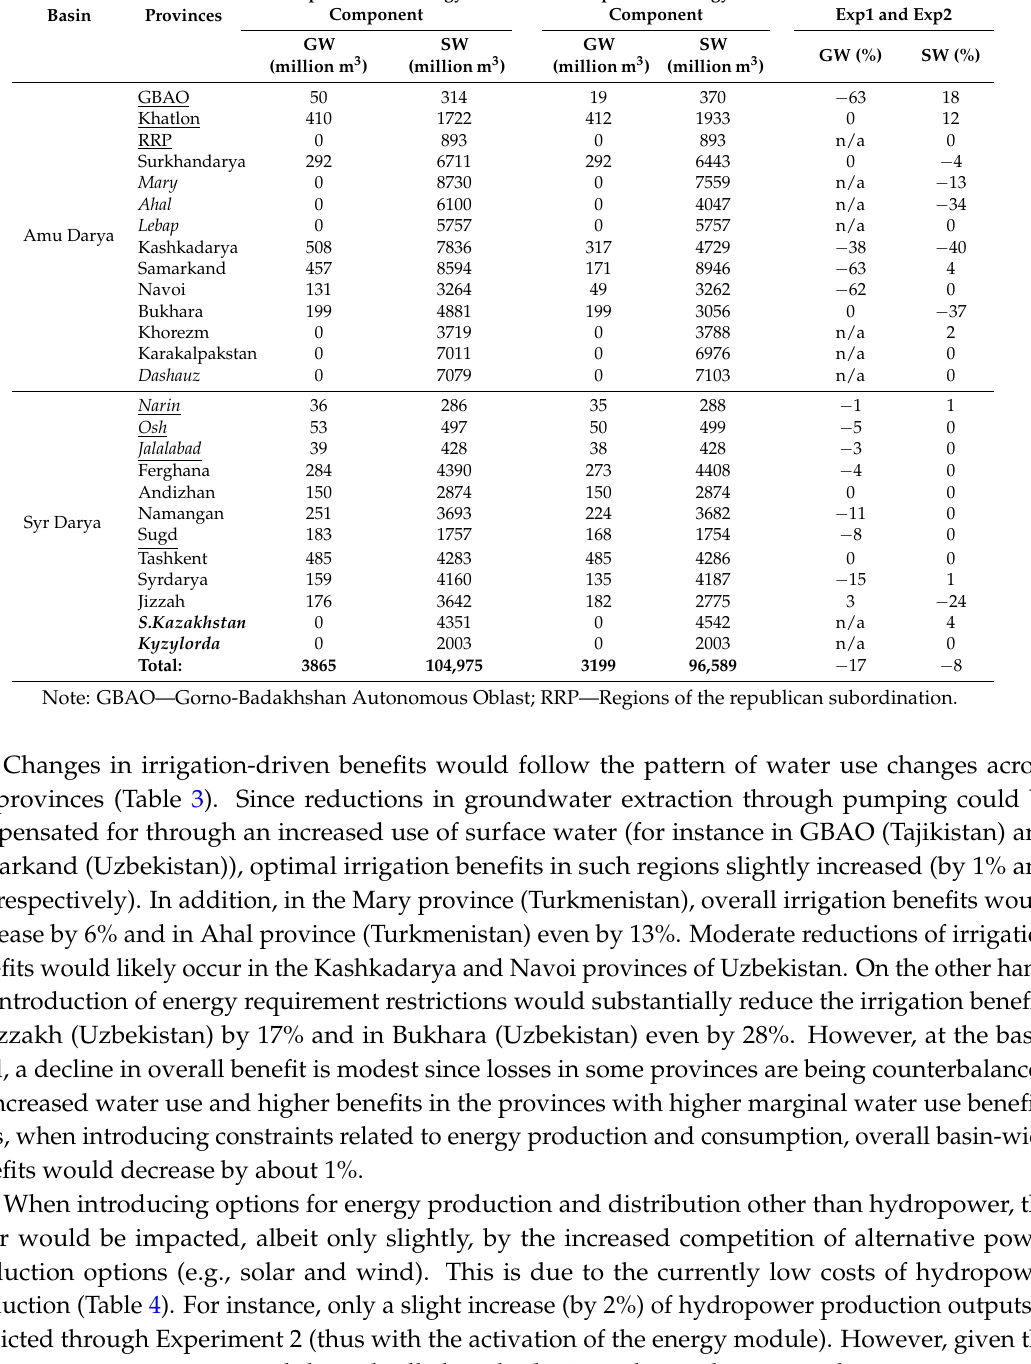
Table 2. Optimal levels of groundwater (GW) and surface water (SW) withdrawals without (Experiment 1) and while (Experiment 2) considering the energy production and consumption sub-module. Provinces underlined are in Tajikistan, those underlined and in italics are in Kyrgyzstan, and those in italics are in Turkmenistan. Provinces in italics and bold are in Kazakhstan, and those in a normal typeface ( i.e. , not underlined, in italics, or bold) are in Uzbekistan. Exp1: Without Energy Exp2: With Energy Difference between Component Component Exp1 and Exp2 Basin Provinces GW SW GW SW GW (%) SW (%) (million m 3 ) (millionm 3 ) (millionm 3 ) (millionm 3 ) GBAO 50 314 19 370 ´ 63 18 Khatlon 1722 8730 Amu Darya